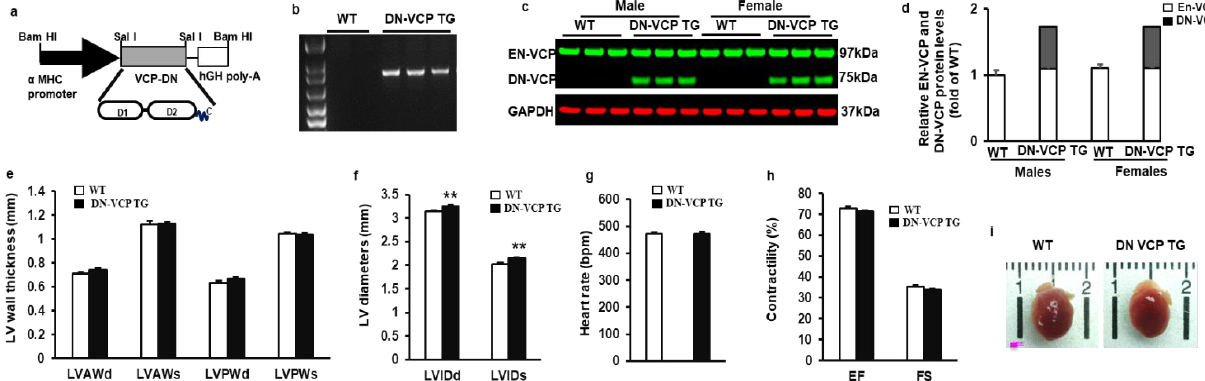
Figure 1. Identification and characterization of cardiac-specific VCP dominant-negative transgenic mouse (DN-VCP TG) at the age of 10 weeks. ( a ). The construct of the cardiac-specific DN-VCP TG mouse model; ( b , c ). Identification of DN-VCP TG by genotyping with PCR ( b ) and protein expression in the hearts by Western blots ( c ); ( d ). the relative value of endogenous VCP (EN-VCP) and overexpressed DN-VCP in TG and WT mice of both genders; ( e – h ). The morphology and function of DN-VCP TG vs. WT by echocardiography at a young age, in terms of left ventricle (LV) wall thickness including LV anterior and posterior wall thickness at end-diastole and end-systole (LVAWd, LVAWs, LVPWd, and LVPWs) ( e ), LV internal end-diastolic and end-systolic dimensions (LVEDd and LVEDs) ( f ), heart rates ( g ), and contractility reflected by LV ejection fraction (EF) and fractional shortening (FS) ( h ). **, p < 0.01 vs. age-matched WT mice. N = 11-12/group; ( i ). The examples of the heart shape and size of DN-VCPTG vs. WT mice at the age of 10 weeks .